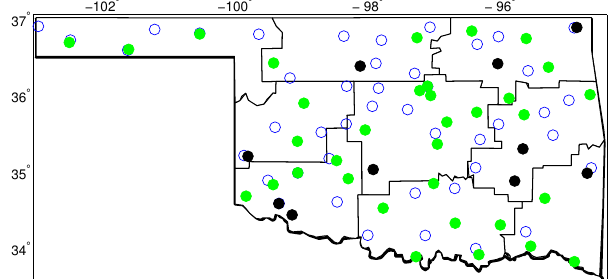
Figure 1. 44 Oklahoma Mesonet stations (filled circles) and 44 USHCN stations (open circles), in which the Oklahoma Mesonet stations include 34 grassland stations (green) and 10 cropland sta- tions (black circles). The MODIS Land Cover product (MOD12Q1) (Friedl et al., 2010) in 2005 was used to classify the Oklahoma Mesonet stations into grassland (34 stations) and cropland stations (10 stations). The thin lines indicate the borders of nine climate di- visions in